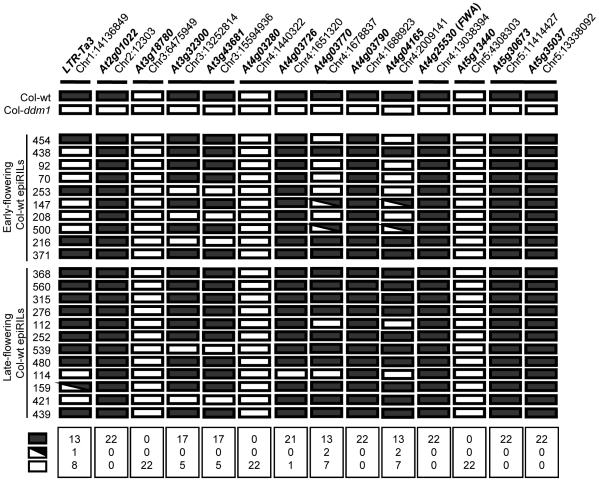
Segregation analysis of DNA methylation in a sample of early and late flowering Col-wt epiRILs.Name and position of probed sequences are indicated at the top. Horizontal bars underneath indicate closely linked sequences. Black and white rectangles represent high (wt) methylation, and absence of methylation or ddm1-induced hypomethylation, respectively. Sectored rectangles represent intermediate methylation levels between Col-wt and Col-ddm1 (for examples of actual methylation measurements, see Figure S1). Segregation of methylation states among the 22 Col-wt epiRILs (F9) is summarized for each sequence at the bottom of the graph.